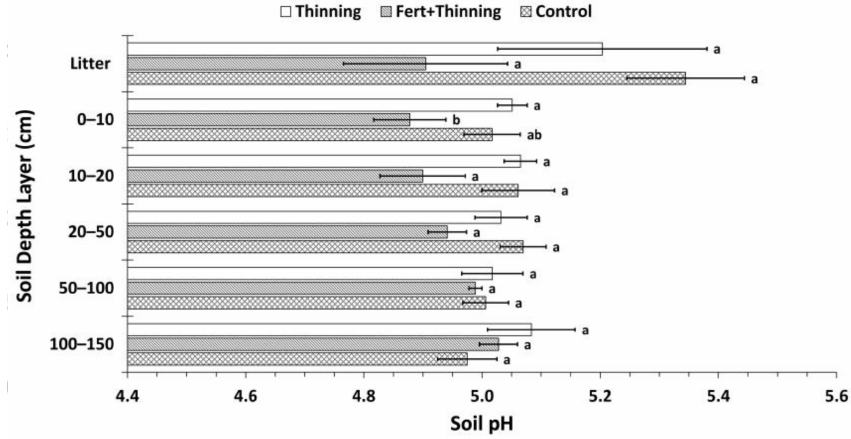
Figure 6. Mean soil pH by treatment. Sample size for all treatments and soil depth layers is three. Error bars represent ± one standard error. Means within each soil depth layer accompanied by the same letter (i.e., “a” or “b”) are not significantly different (Tukey’s HSD, α = 0.1). Fert,